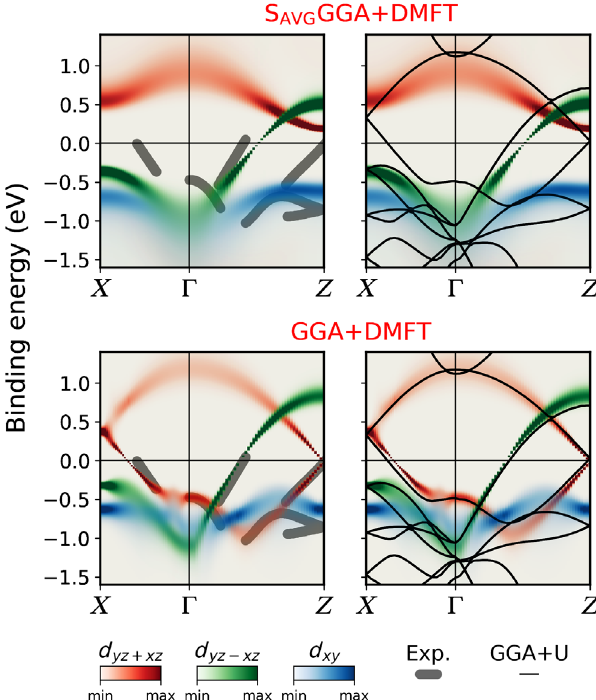
FIG. 4. Momentum-resolved spectral functions for the majority spin channel within S GGA þ DMFT (top panels) and AVG GGA þ DMFT (bottom panels) compared with experimental bands extracted from ARPES (left panels) and GGA þ U ¼ 0 . 4 eV (right calculations with U eff